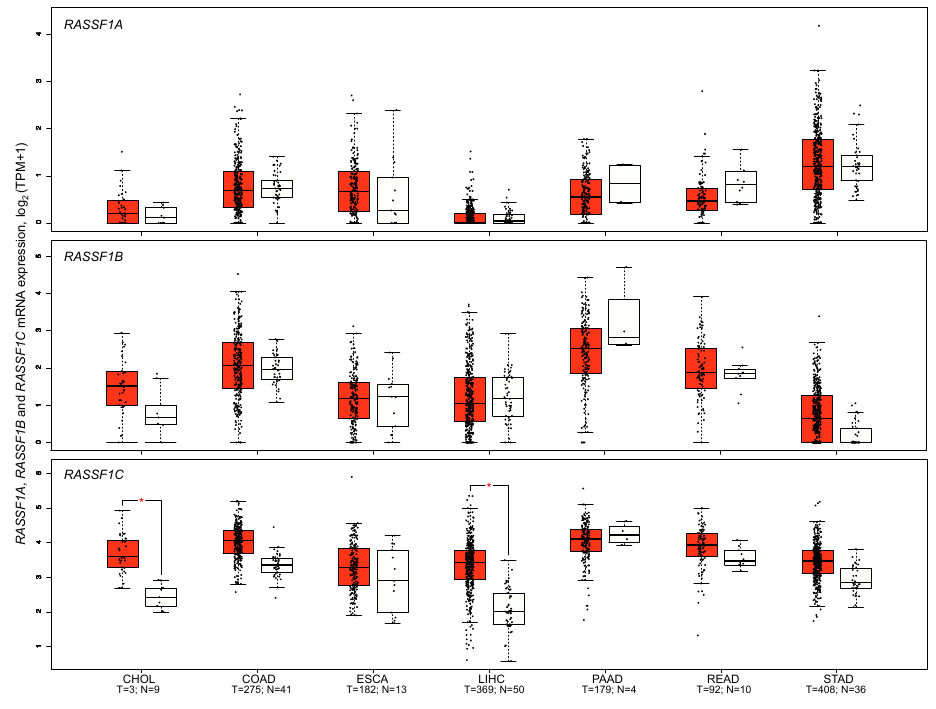
Figure 4. mRNA level of RASSF1A , RASSF1B , RASSF1C in seven gastrointestinal cancer types and the corresponding normal tissues. Red box, cancer types; white box normal tissues. The box plots show the expression distribution of the RASSF1 isoforms RASSF1A , RASSF1B , and RASSF1C in the cancer types indicated in figure and the respective normal tissues. The expression levels of the samples are represented by black points. The expression data are log 2 of Transcripts Per Million plus 1 (TPM + 1) transformed for di ff erential analysis and the log 2 fold change defined as median of cancers minus median of normal tissues. Expression data of cancer and normal samples derived from the TCGA. Box plot represents the 25th percentile interval and whiskers represent the 95th percentile interval of the distribution. A horizontal line indicates the median value of the expressions. The number of samples for each series in cancers (T) and normal (N) is indicated below the acronym of cancer. CHOL, cholangiocarcinoma; COAD, colon adenocarcinoma; ESCA, esophageal carcinoma; LIHC, liver hepatocellular carcinoma; PAAD, pancreatic adenocarcinoma; READ, rectum adenocarcinoma; STAD, stomach adenocarcinoma. The asterisk indicates a significant di ff erence of expression between a cancer type and the corresponding normal tissues ( p < 0.01). Graphs were obtained from GEPIA2 at http: //